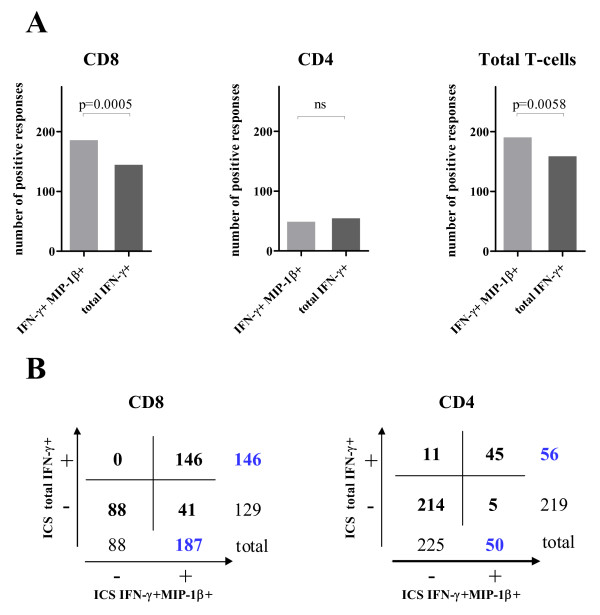
Number of detected positive responses. (A) The histogram plots show the number of positive CD8, CD4 or total T-cell responses detected with the IFN-γ+ MIP-1β+ and the total IFN-γ+ data evaluation systems. The p values (Fisher's exact test) are shown for each graph. Not significant difference (ns). (B) 2 × 2 contingency tables comparing the two data evaluation systems are shown for CD8 and CD4 T-cell responses.